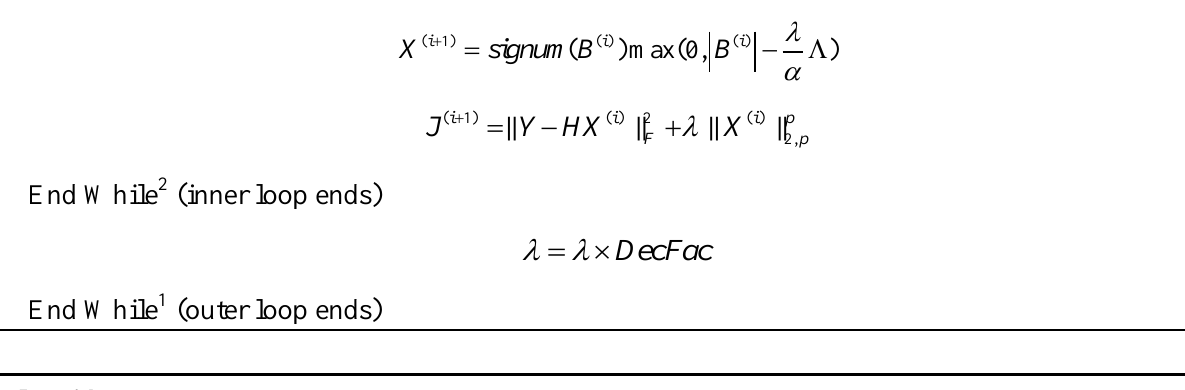
Algorithm 4: Analysis Prior